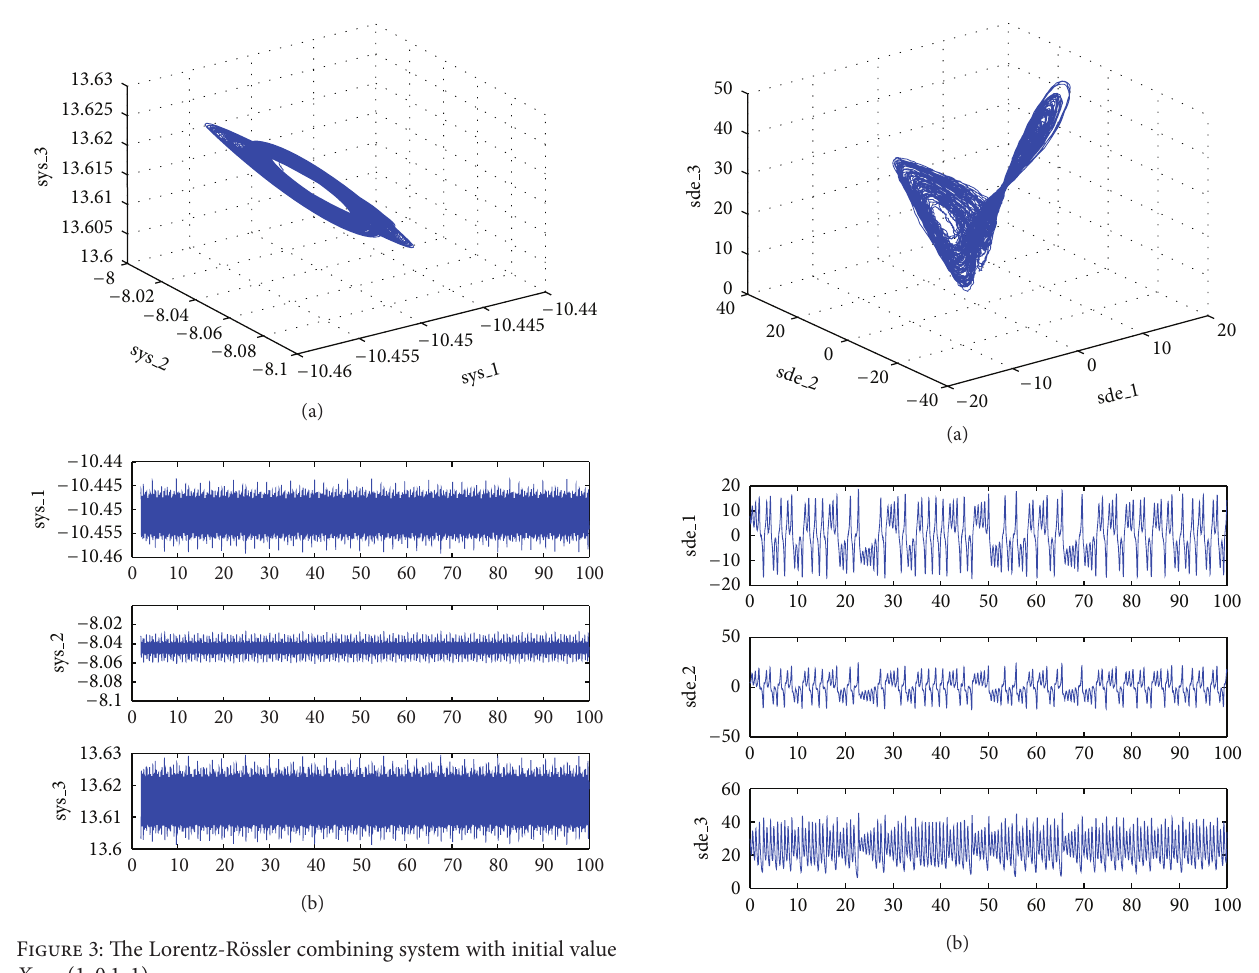
Figure 4: The attractor and the time series of the stochastic Lorentz system with a standard irrelated white noise ( 𝑢 𝑖𝑖 = 1 , 𝑢 𝑖𝑗,𝑖 ̸=𝑗 = 1 , 𝑖, 𝑗 = 1,2, 3